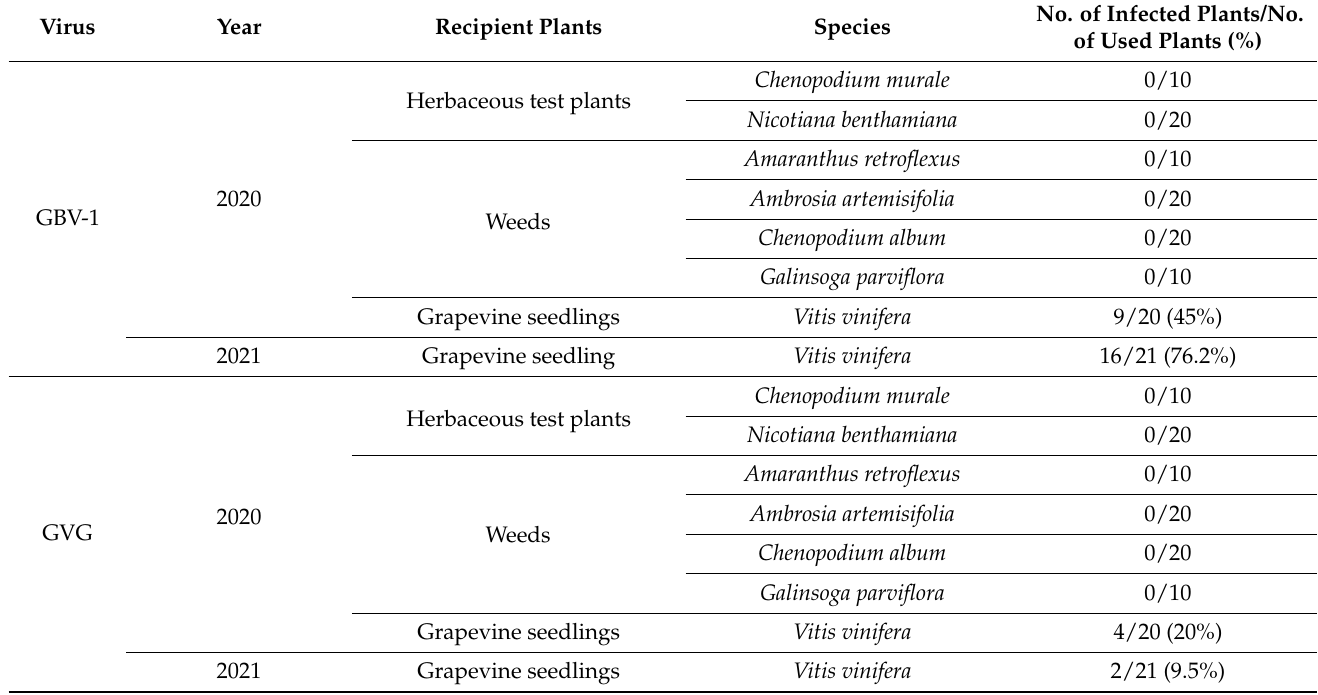
Table 1. Results of vine mealybug ( P. ficus ) transmission of GBV-1 and GVG using different recipient